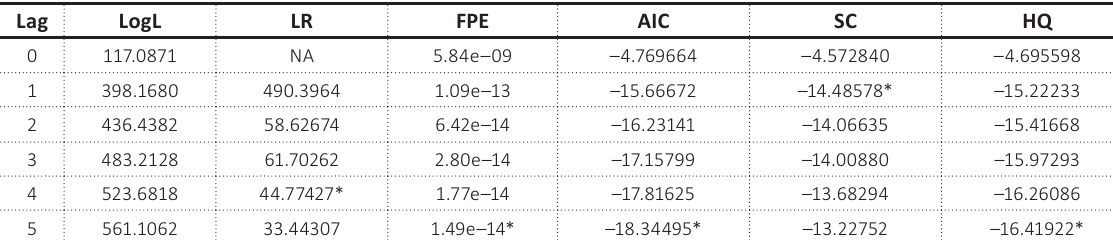
Table 2. Lag criteria test